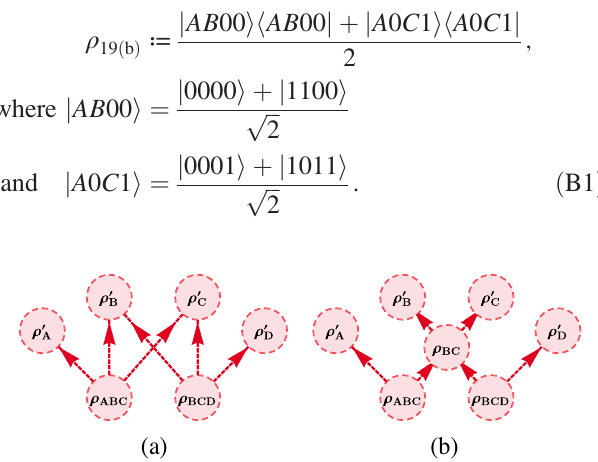
FIG. 19. Inequivalent state generating procedures. (a) depicts a two-layer state generating procedure, whereas (b) allows for the application of an arbitrary Bob-Charlie channel, generating the intermediate state ρ BC , prior to distributing Hilbert spaces to the four parties. One can confirm that (a) generates a strict subset of the states realizable in (b), and quantum inflation can distinguish these two scenarios in a device-independent